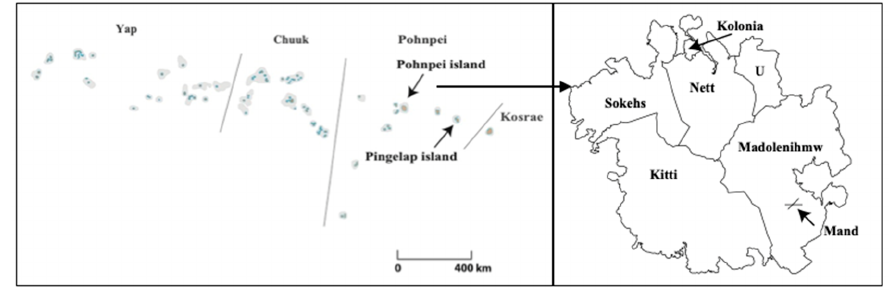
Figure 1. Geographic location of Pingelap Island and Mand.